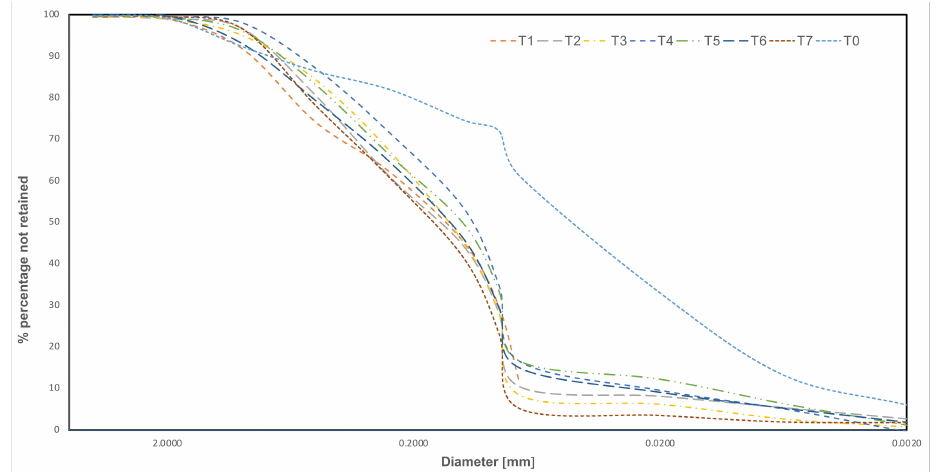
Figure 1. Particle size distribution curve of the treated soil after three months. T0: Soil without treatment; T1, T2, and T3: soils treated with lime at 1, 2, and 3%, respectively; T4, T5, and T6: soils treated with 40 nm silica nanoparticles at 0.5, 1, and 2%, respectively; T7: soil treated with 0.5% nanosilica and 2%